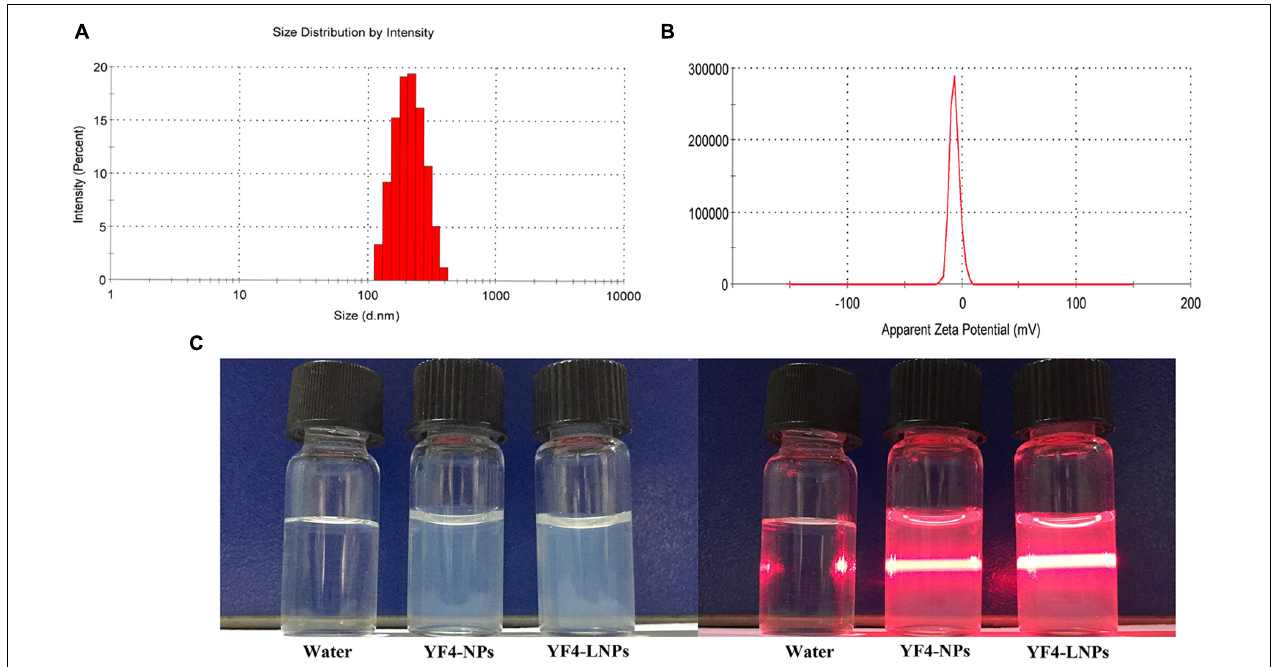
FIGURE 2 | Physical-chemical properties of YF4-LNPs. (A) Size distribution. (B) Zeta potential. (C) The appearance of